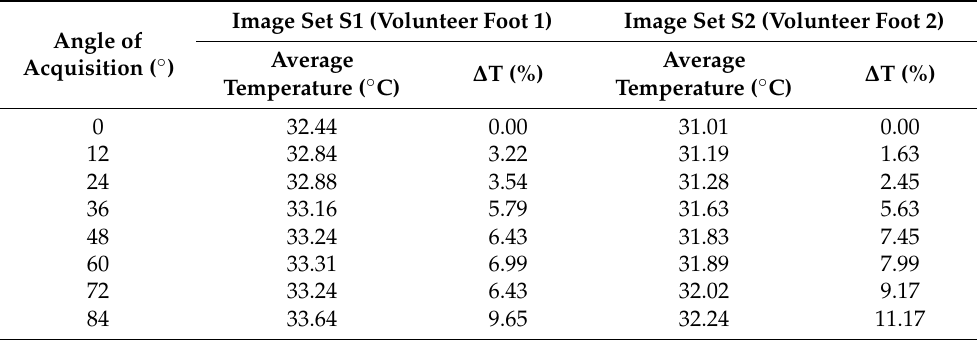
Table 9. ∆ T regarding the angle of measurement. The temperature was compensated in the original thermal arrays with the calculated